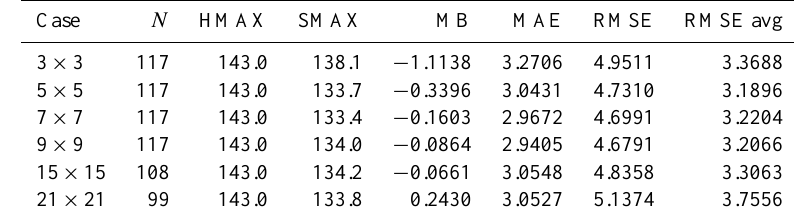
Table 7. As above but with different starting positions corresponding to the 25 and 30 CMAQ column and row, respectively.